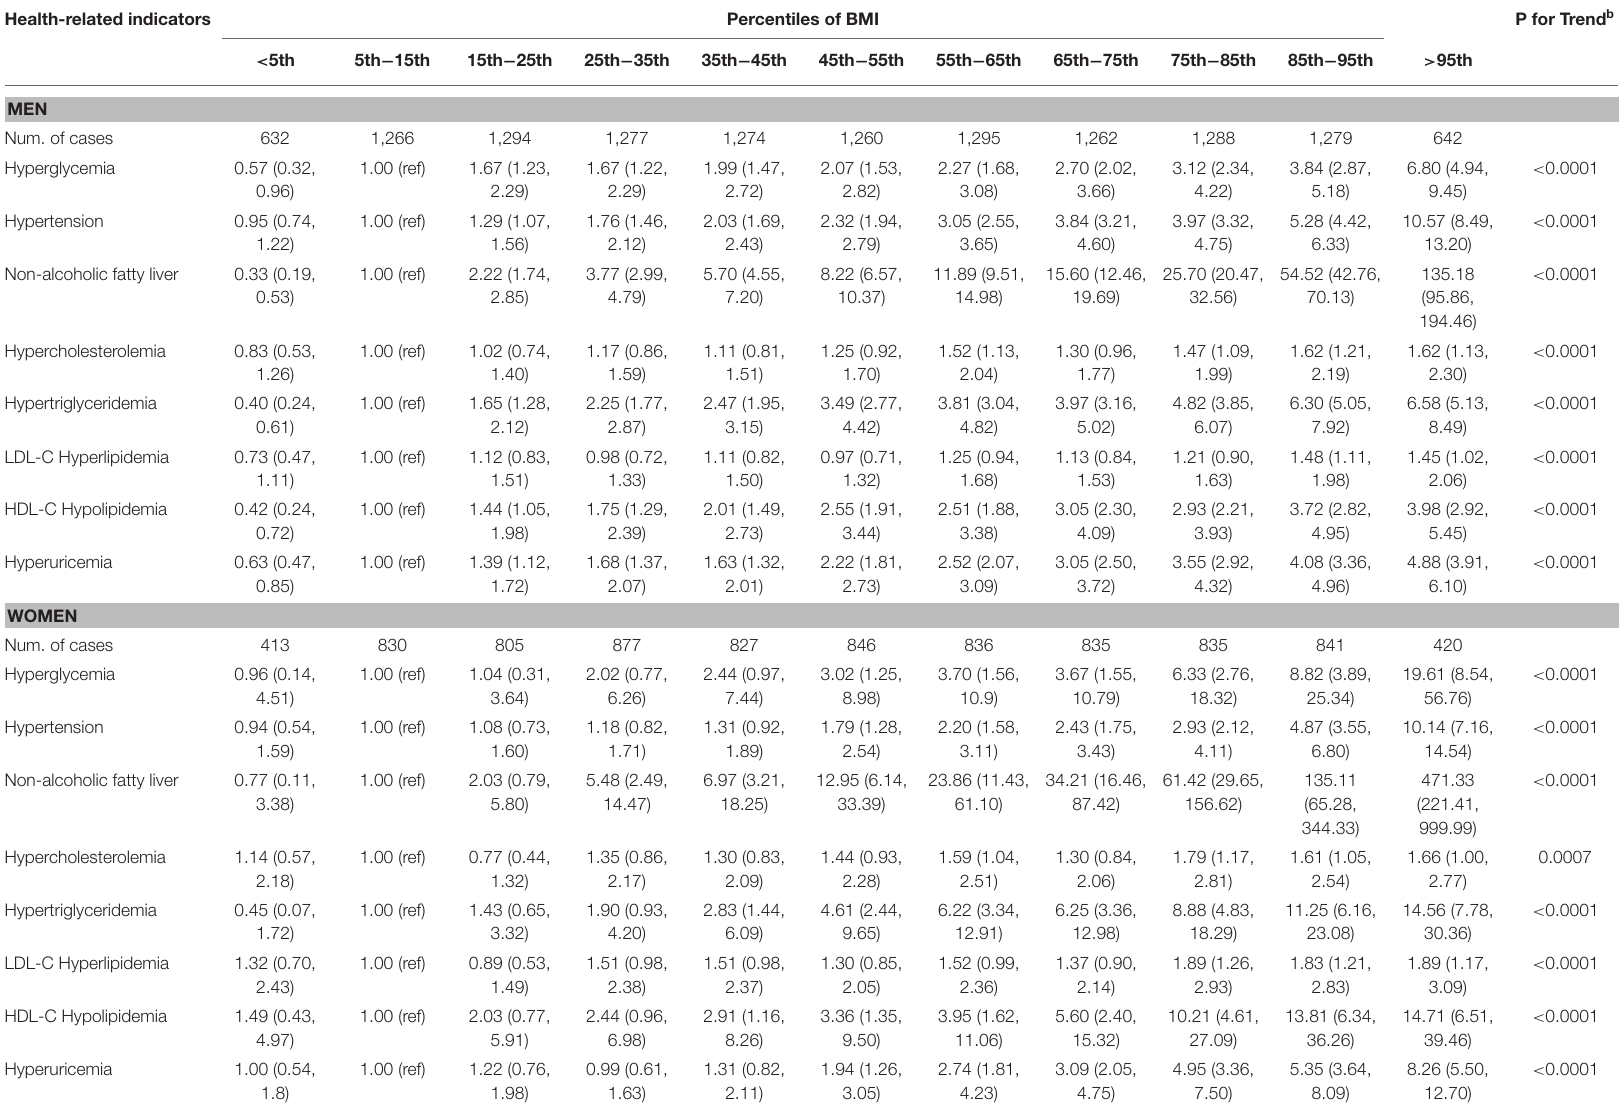
TABLE 2 | Age- and history of diseases-adjusted odds ratios with 95% confidence intervals for the association of sex-specific percentiles of BMI and health-related indicators stratified by sex a . Health-related indicators Percentiles of BMI P for Trend